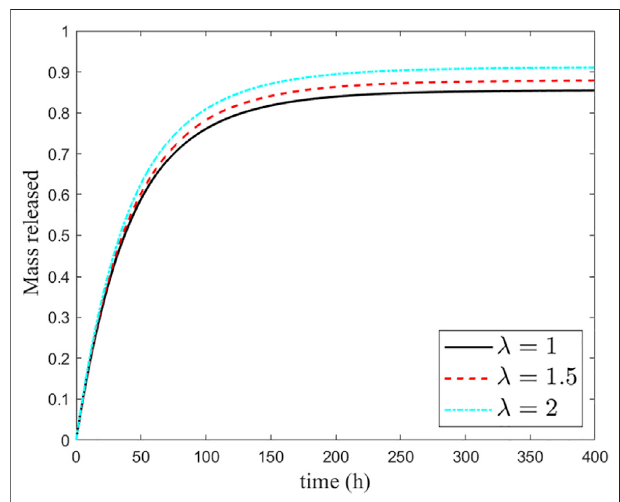
FIGURE 8 | Sensitivity of the release curves to ellipse eccentricity λ